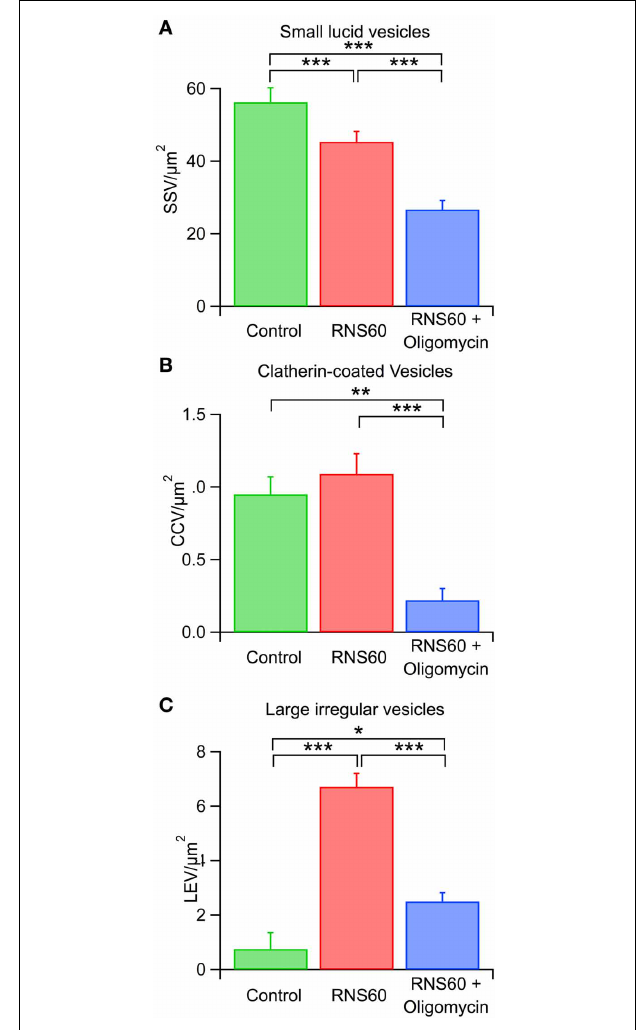
FIGURE 7 | Effect of RNS60 and oligomycin on synaptic vesicle numbers. (A) Number of lucid small synaptic vesicles after superfusion with control (green), RNS60 (red), or RNS60 after presynaptic injection of oligomycin (blue) in the presence of RNS60. (B) Number of clatherin-coated vesicles under the same three conditions as in panel (A) . (C) Number of large, irregular vesicles under the same three conditions as in panel (A) . ∗∗∗ p < 0 . 0001, ∗∗ p < 0 . 001, ∗ p < 0 . 05, Kruskal-Wakkus test.